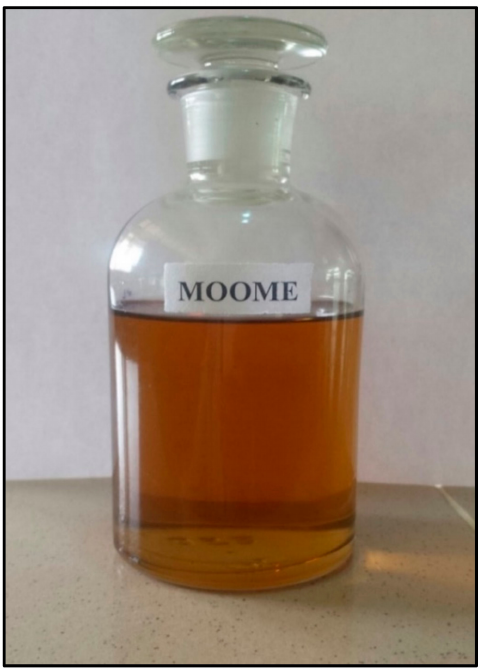
Figure 8. Sample of MOOME produced.